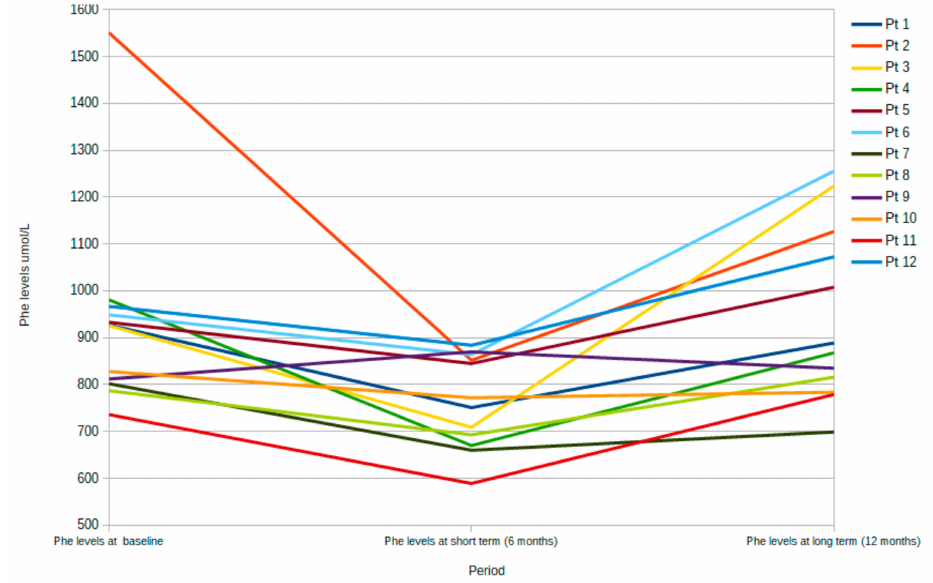
Figure 4. Phe level at each time point: baseline, after 6 months (short term) and 12 months (long term) of LNAA treatment for each patient.